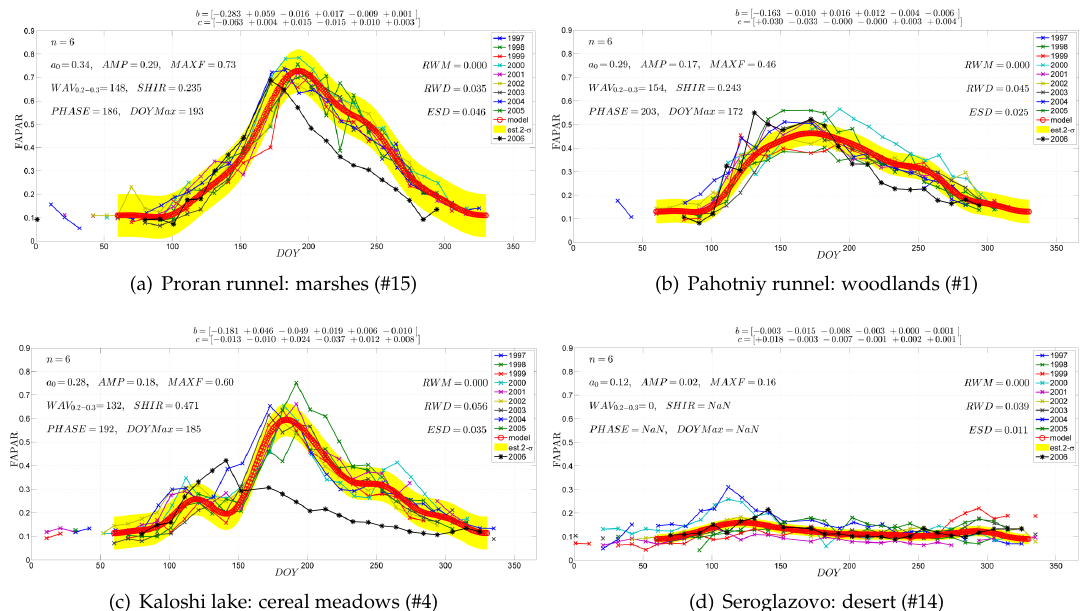
Figure 2. Model curves of the fraction of absorbed photosynthetically-active radiation (FAPAR) temporal dynamics along with theoretically-estimated 2- σ corridors and numerical results, including model-derived indices, compared to actual data for land sites with different types of plant cover, with the anomalous 2006 given using distinct markers and color: ( a ) marshes near Proran runnel, ( b ) woodlands near Pahotniy runnel, ( c ) cereal meadows around Kaloshi lake, ( d ) desert near